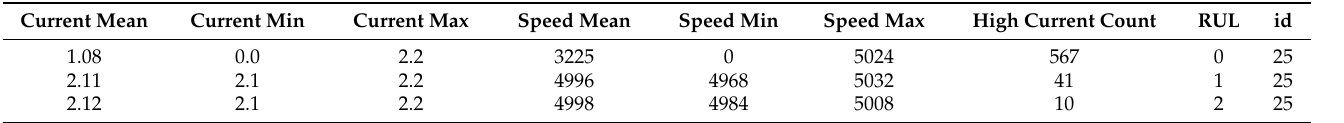
Table 2. Sample test